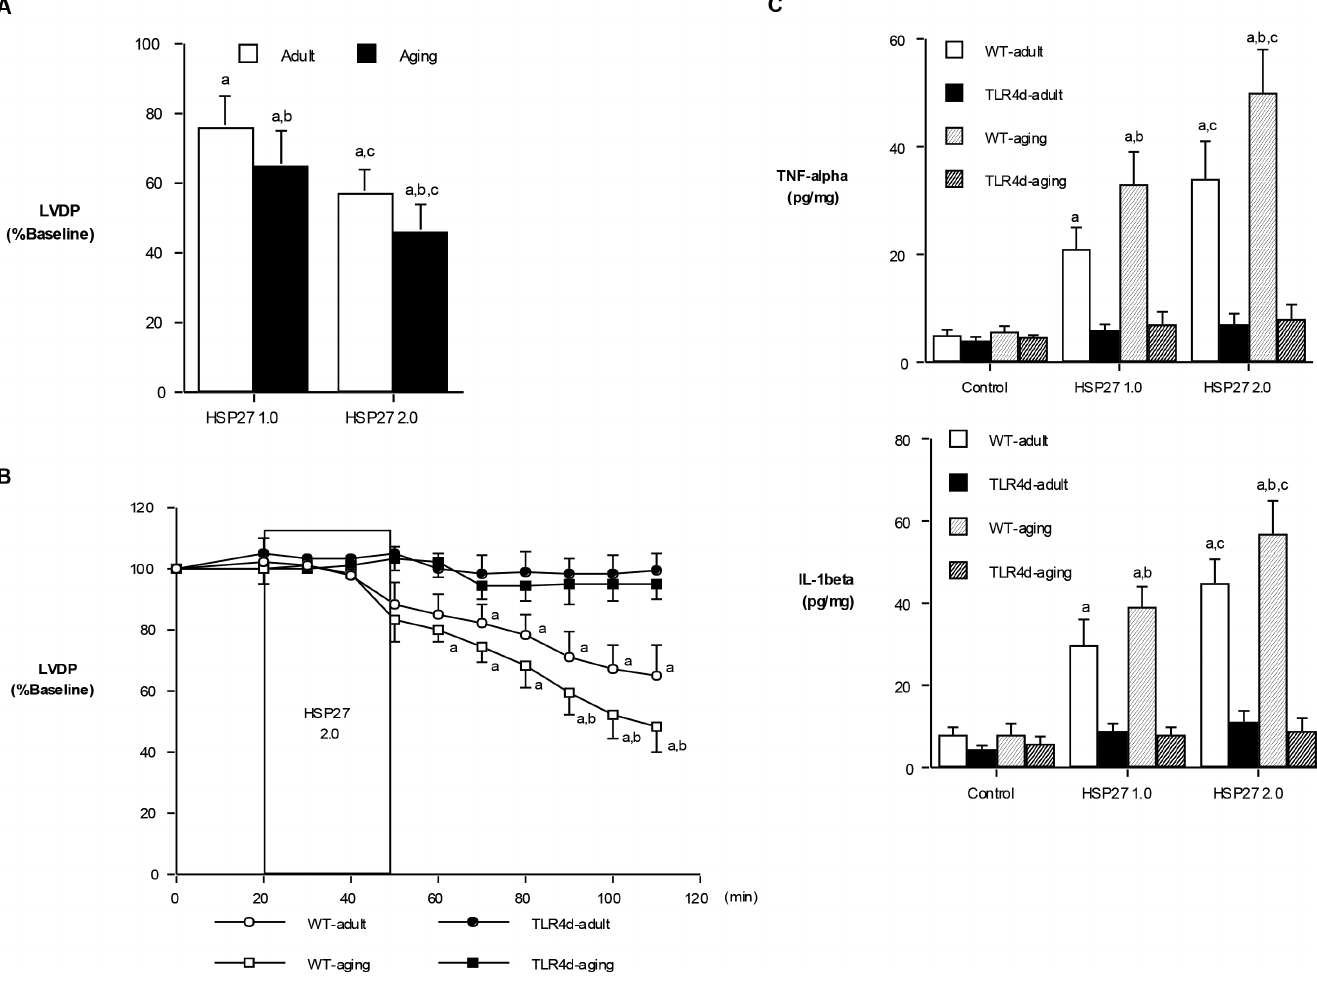
Interestingly, augmented release of HSP27 in aging hearts is associated with enhanced myocardial inflammatory re- sponse and attenuated cardiac functional recovery following global I/R. Two lines of evidence suggest an important role of extracellular HSP27 in the